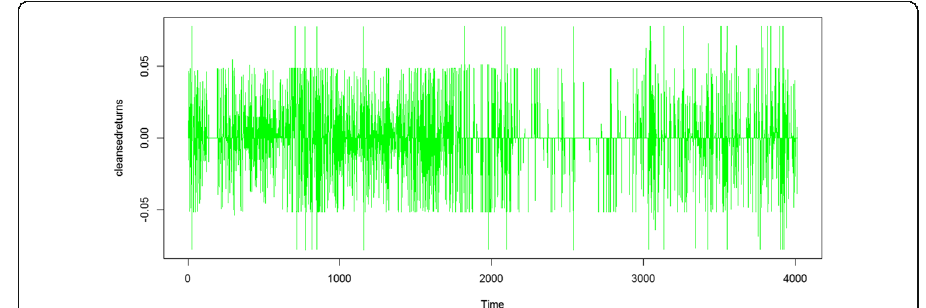
Fig. 4 Plot cleansed log returns of Total Nigeria Plc